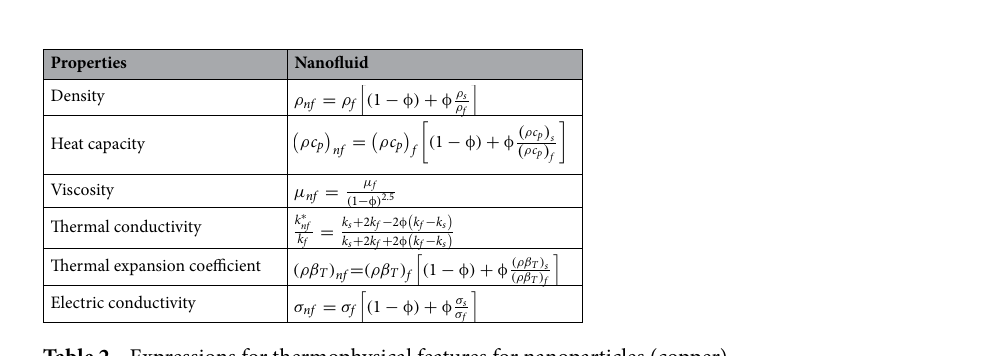
Table 2. Expressions for thermophysical features for nanoparticles (copper).